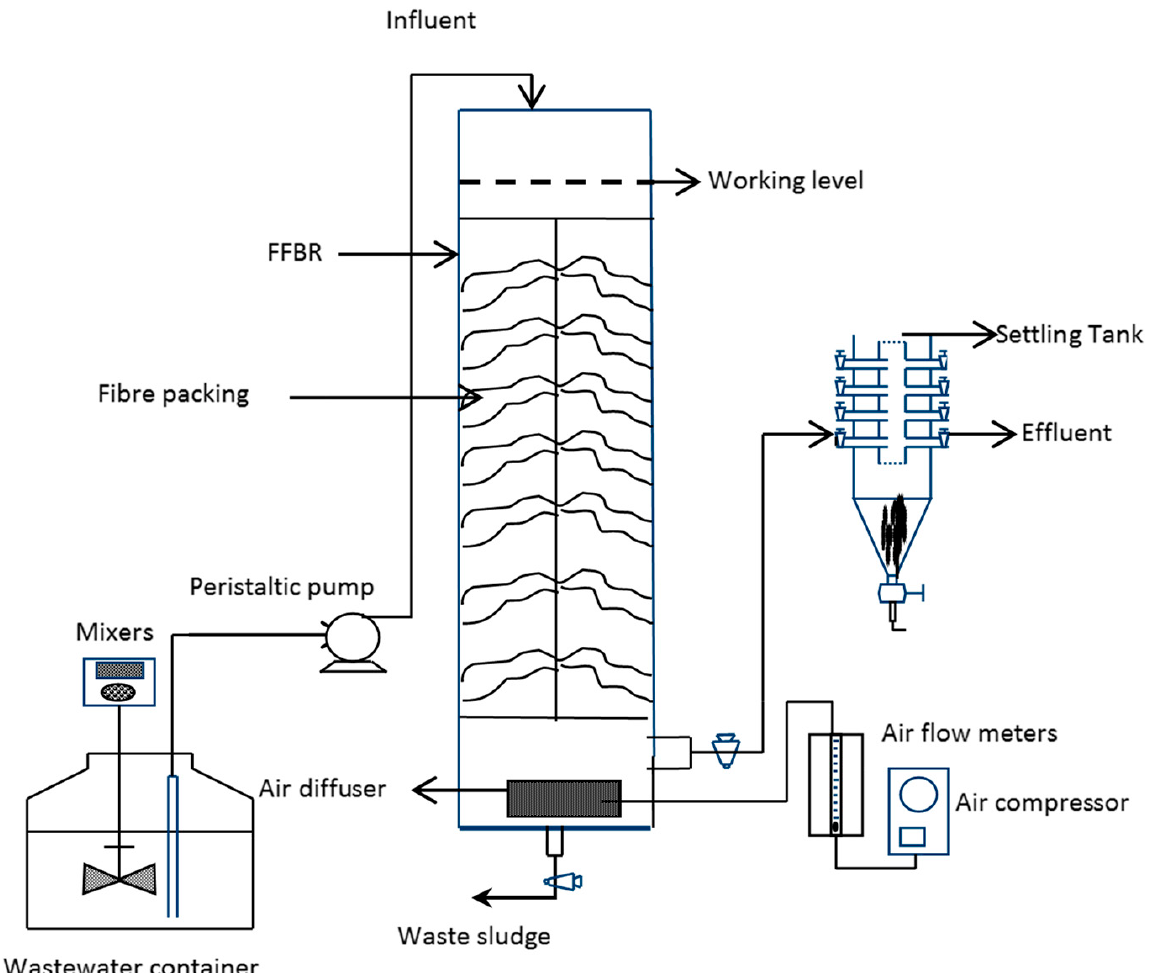
Figure 1. Schematic of SS-FFBR set-up used in this study.